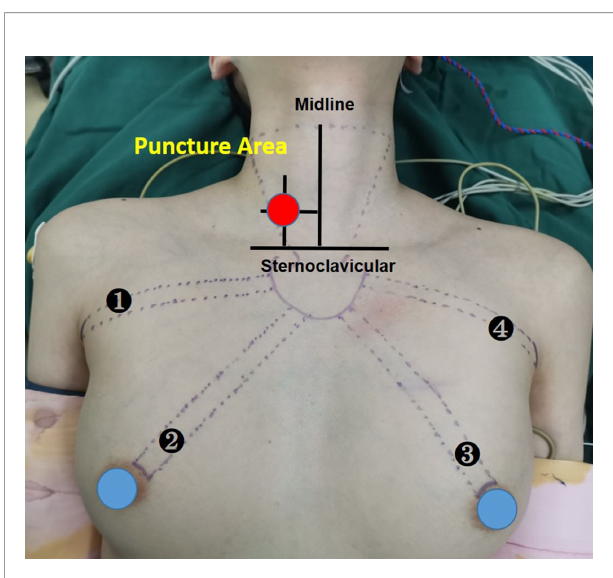
FIGURE 1 | Selection of puncture point for nerve-monitoring probe.